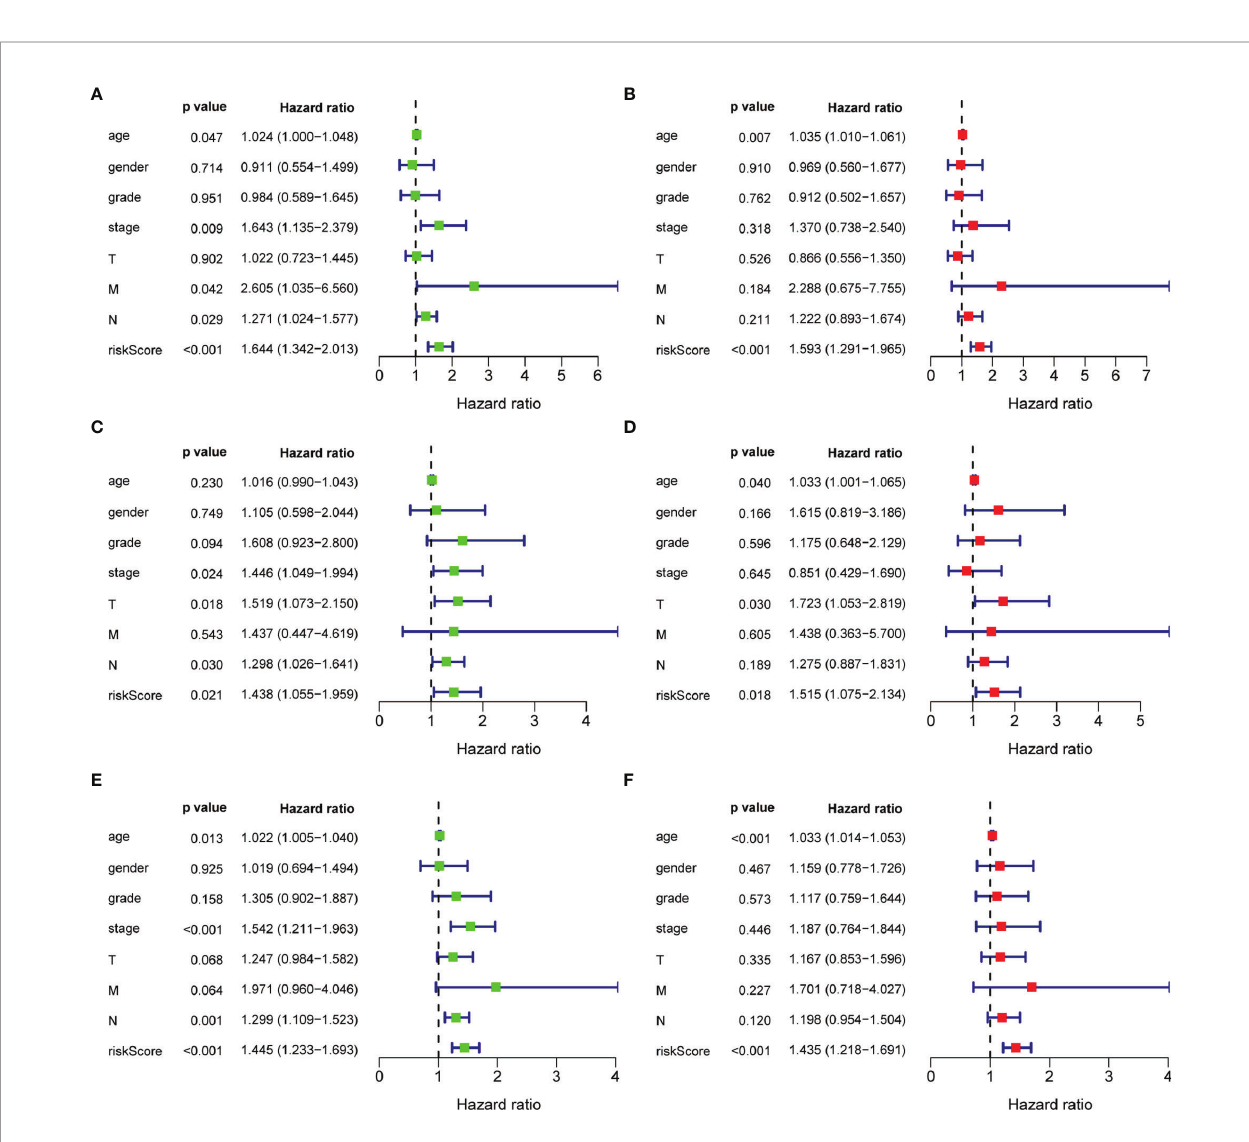
FIGURE 5 | Risk prognostic model in ROC curve of three groups. (A) Training set; (B) Testing set; (C) All set. the abscissa represents the true positive rate (sensitivity), and the ordinate represents the false positive rate (1-speci fi city).